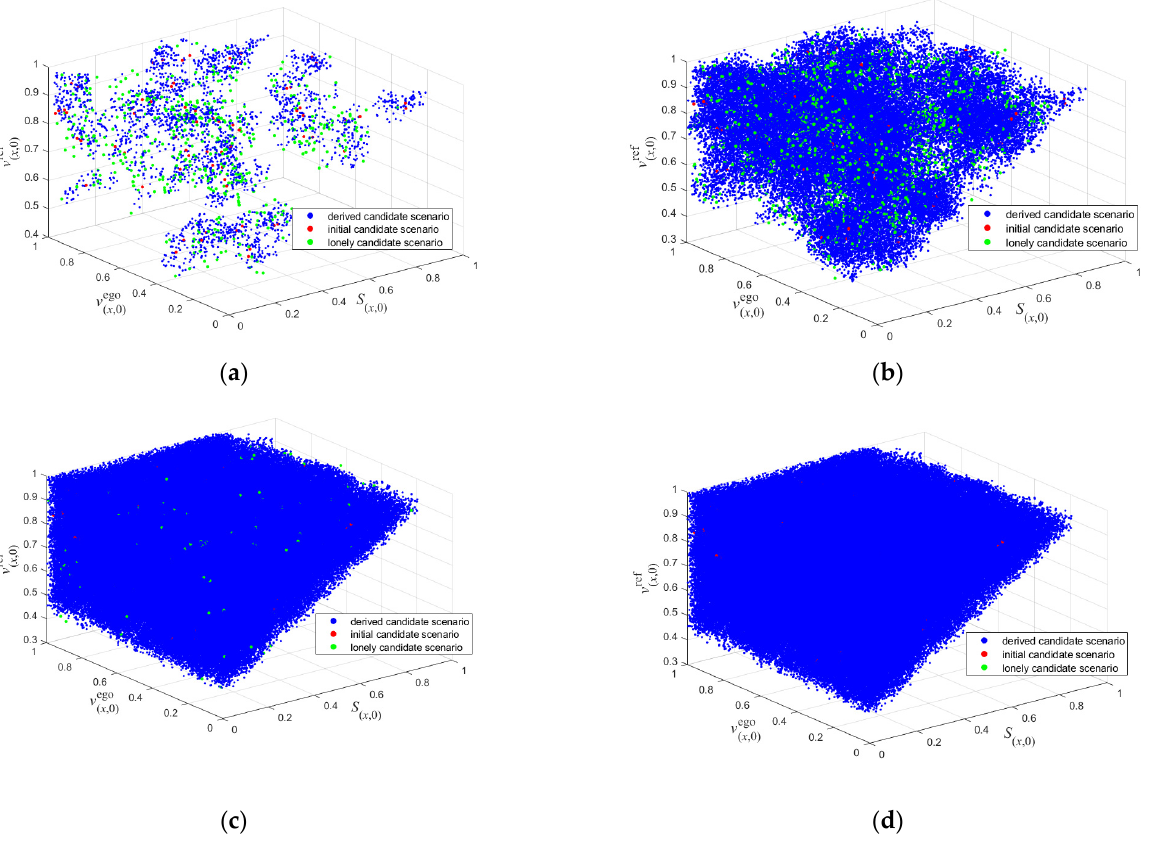
Figure 16. Derived, initial, and lonely candidate scenarios. Red circles are initial candidate scenarios. Green and red circles are derived from candidate and lonely scenarios, respectively. ( a ) Iteration = 1; ( b ) Iteration = 3; ( c ) Iteration = 10; ( d ) Iteration = 44.